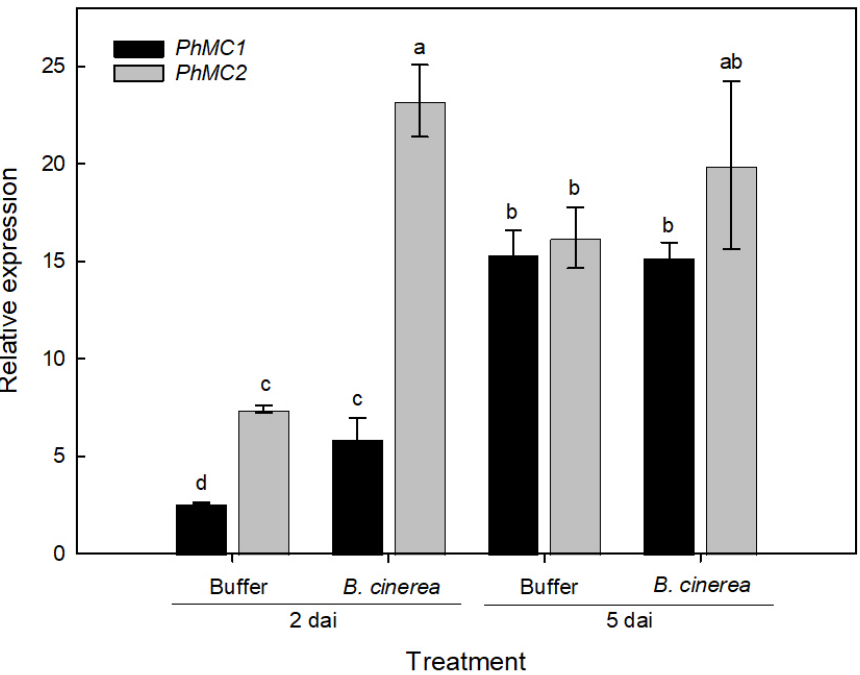
Figure 5. Metacaspase gene expression in petunia leaves after Botrytis cinerea infection. Petunia × hybrida ‘Mitchell Diploid’ detached leaves were inoculated with B. cinerea spores and evaluated at 2 or 5 days after inoculation (dai). Abundance of PhMC1 and PhMC2 transcripts were determined relative to PhACTIN by quantitative PCR. Bars represent mean ± SD ( n = 3). Different letters represent statistically significant difference between the means ( p ≤